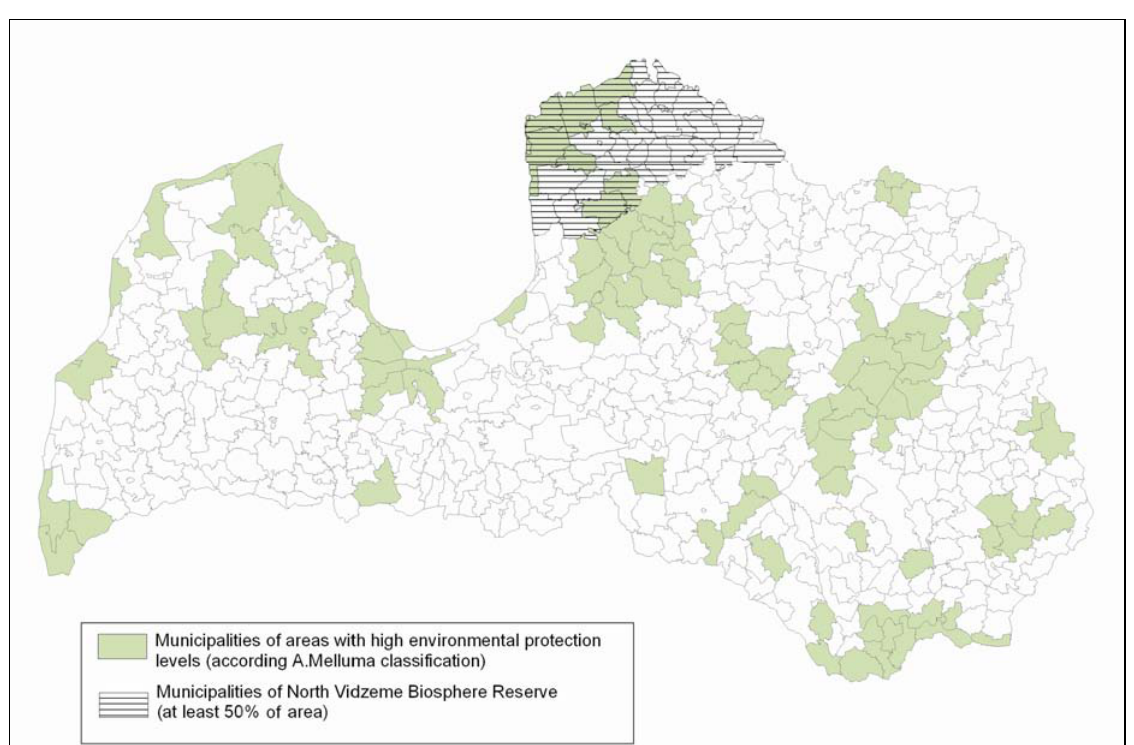
Fig. 3. Placement of municipalities of the North Vidzeme Biosphere Reserve (at least 50 % of area) and municipalities of areas with high environmental protection levels (according to a classification by A. Melluma) in